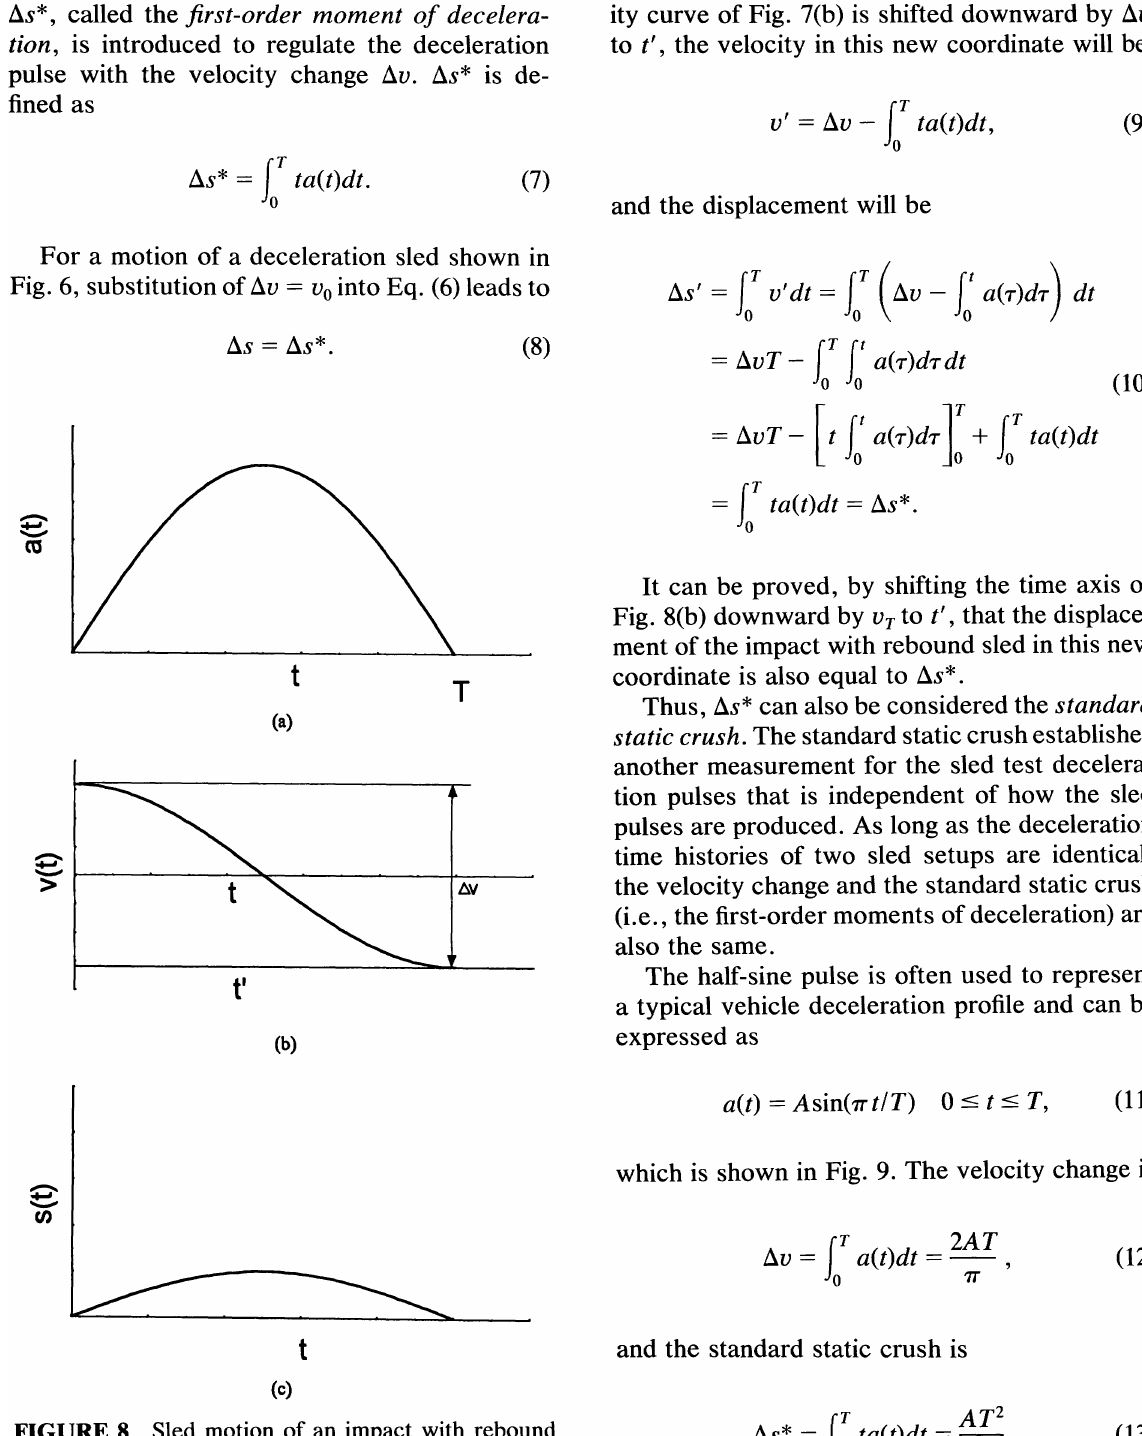
FIGURE 8 Sled motion of an impact with rebound